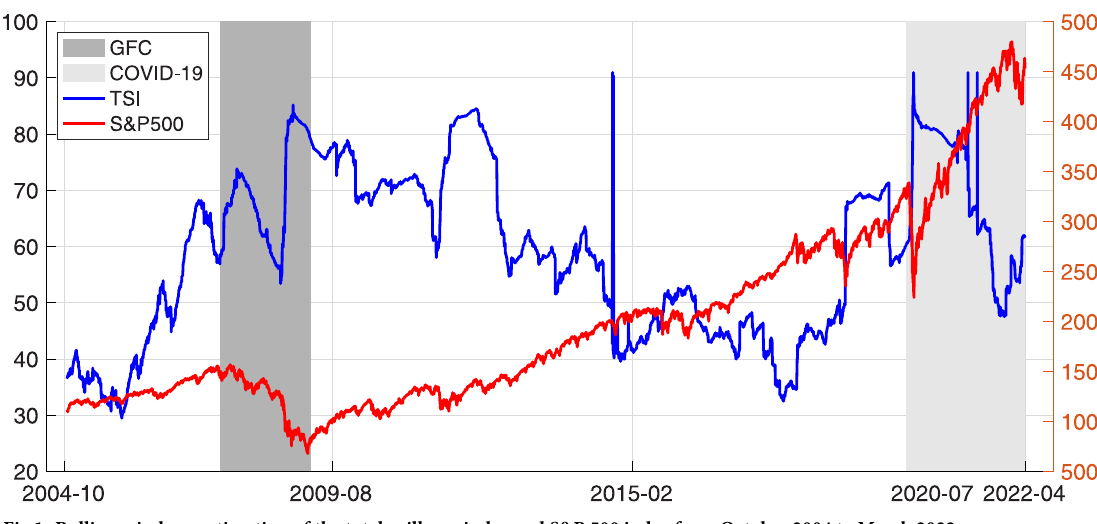
Fig 1. Rolling-windows estimation of the total spillover index and S&P 500 index from October 2004 to March